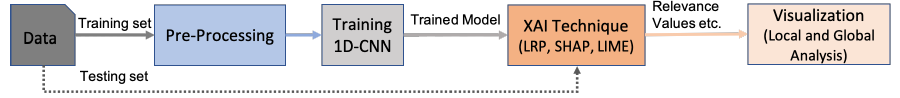
Figure 1. Overall architecture of the proposed